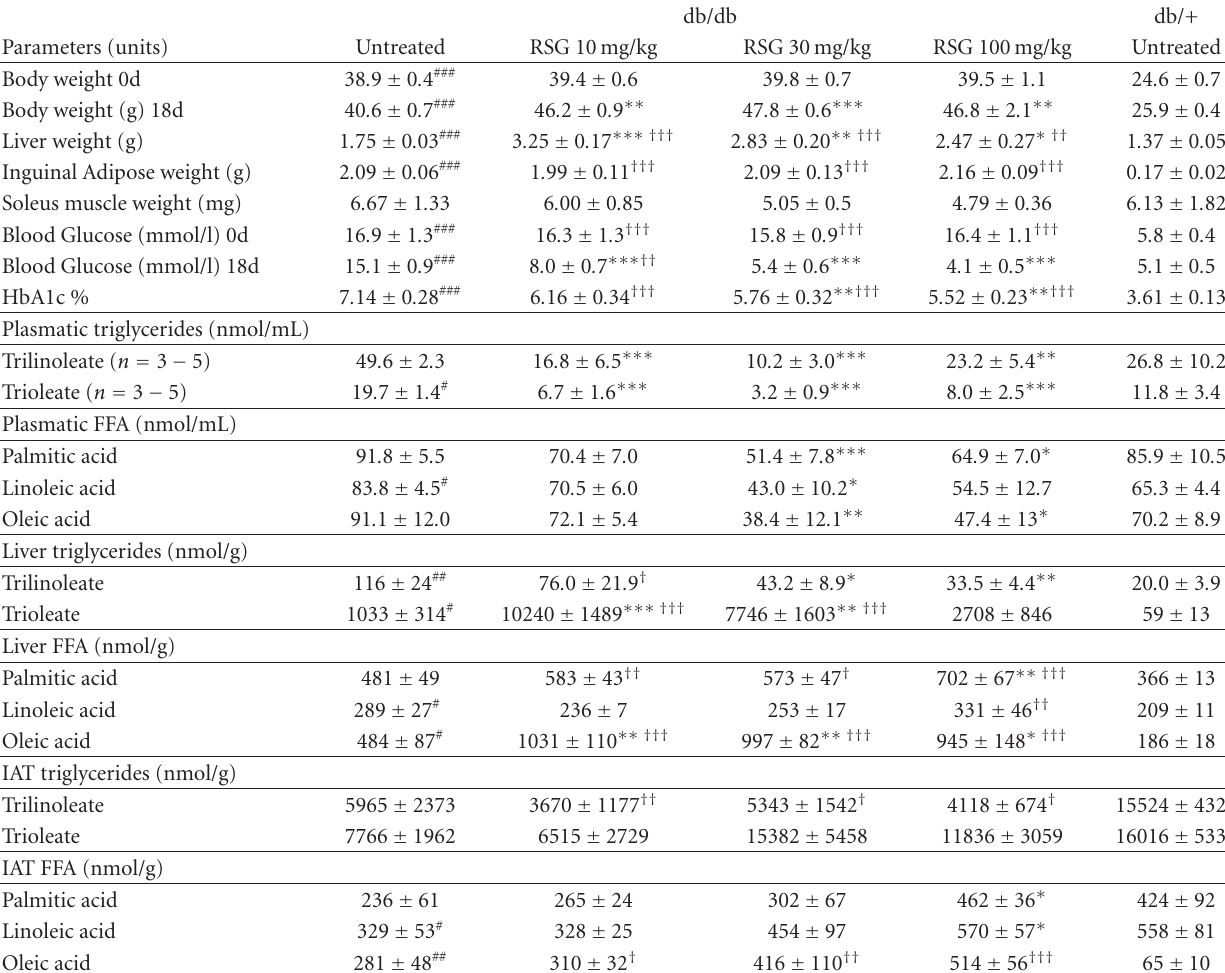
Table 1: Animal characteristics, blood and tissue analysis: db/db were compared by Student’s “ t ” test versus db + , # P < . 05; ## P < . 01; ### P < . 001. RSG-treated groups were compared by ANOVA and Dunnett test versus untreated db/db, ∗ P < . 05; ∗∗ P < . 01; ∗∗∗ P < . 001, or